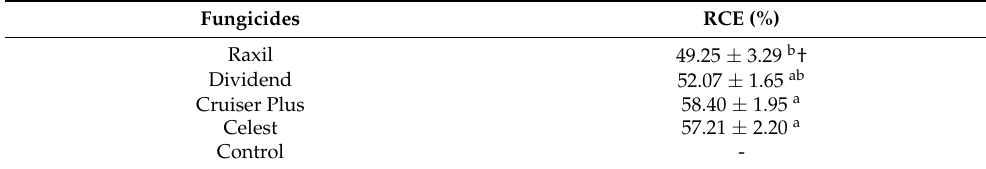
Table 2. Relative control efficacies of four fungicides to wheat FCR in a pot assay.